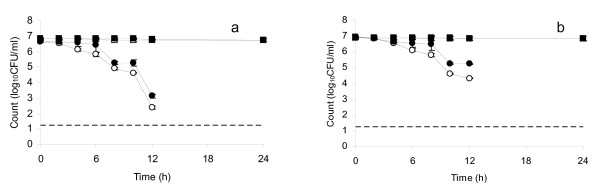
Plate counts of (a) S. Typhimurium 98 and (b) S. Typhimurium 1251 in distilled water at pH 7.0, 30°C stored in a copper vessel and enumerated under aerobic conditions (open circles) and ROS-n conditions (closed circles); (a) S. Typhimurium 98 and (b) S. Typhimurium 1251 in distilled water at pH 7.0, 30°C stored in a glass vessel and enumerated under aerobic conditions (open squares) and ROS-n conditions (closed squares). Error bars represent 95% confidence limits (n = 3). No counts were obtained at 24 h under any conditions. No counts were obtained after 12 h for bacteria kept in water in the copper vessel.